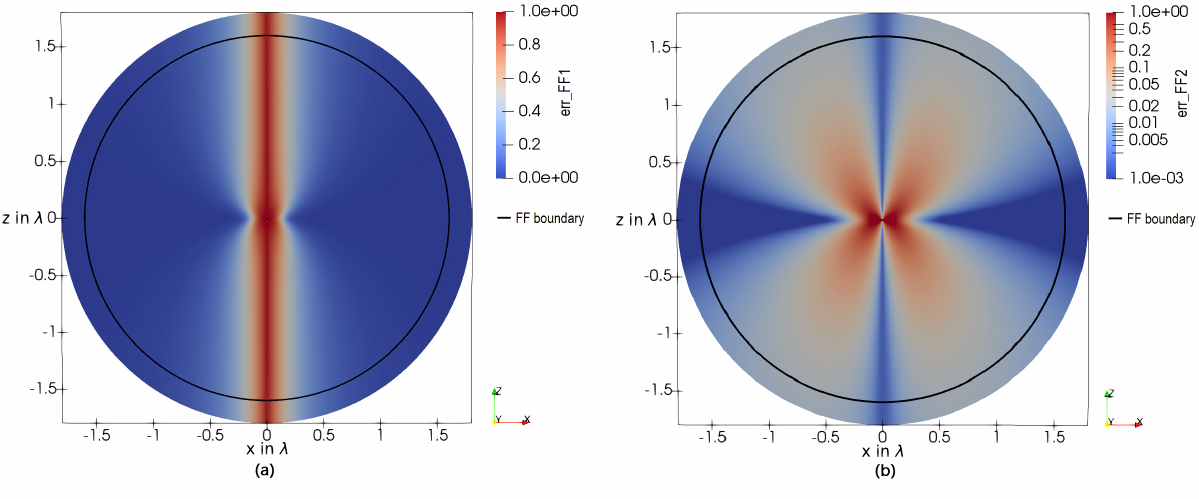
Figure 5. ( a ) The error-estimator 5, describing the radial and real portion of the power flow applied on an HD in the E-plane. ( b ) The error-estimator 6 applied on an HD in the E-plane, describing the error-estimator weighted with the directivity D ( θ , φ ) . The FF boundary r far for very small antennas is displayed as a black